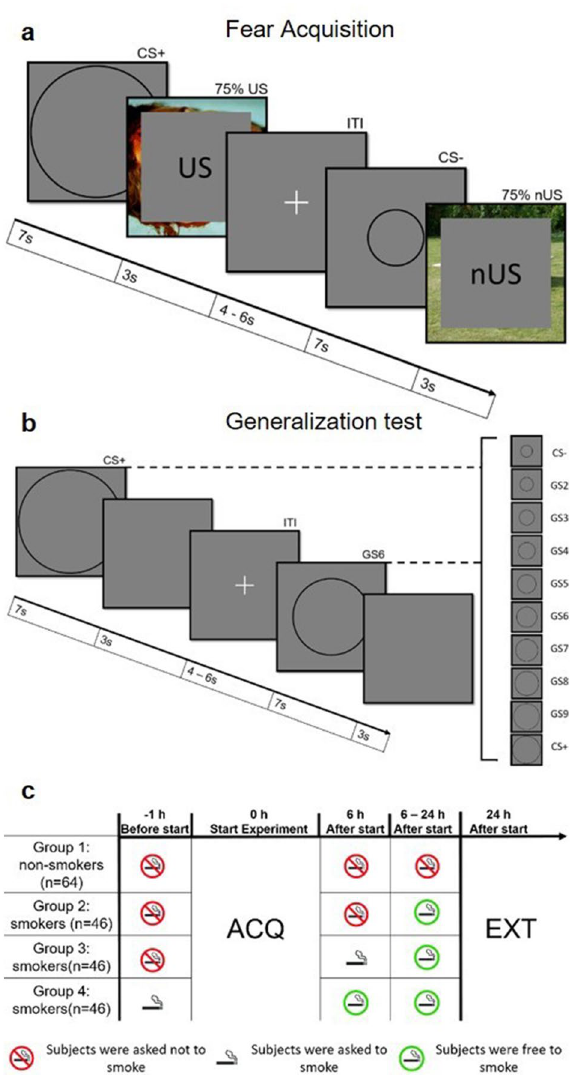
Figure 4. Experimental procedure. ( a ) Day 1: Fear acquisition. The CS + was followed in 75% of the time by an aversive picture, which served as US. The CS− was followed in 75% of the time by a neutral picture, which served as nUS. When not followed by a picture, CSs were fading into the grey background (1 s). Per trial a CS was presented for 7 s followed by a 1 s overlap of CS and US/nUS and then a 2 s only presentation of US/nUS. After each trial the ITI was presented (jittered between 4 and 6 s). Size of rings serving as CS + and CS− was counterbalanced. ( b ) Day 2: Generalization test. In addition to CS + and CS- serving as extremes, 8 rings of gradually increasing size were introduced as generalized stimuli (GS). After a 7 s presentation the CS or GS faded into the grey background. After each trial the ITI was presented (jittered between 4 and 6 s). ( c ) Group formation. The non-smoking group (group 1) did not smoke at all during the experiment. Group 2 (smokers) was asked not to smoke 1 h before and 6 h after the experiment on day 1. Group 3 (smokers) was asked not to smoke 1 h before the experiment and to smoke directly after the experiment on day 1. Group (smokers) 4 was asked to smoke directly before the experiment on day